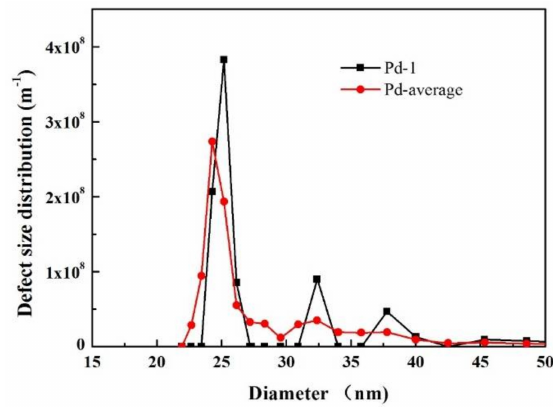
Figure 12. Averaged defect size distribution for Pd composite membranes derived from six replicate runs and four replicate samples. Table 9. Summary of MLLDP results for six replicate runs of Pd composite